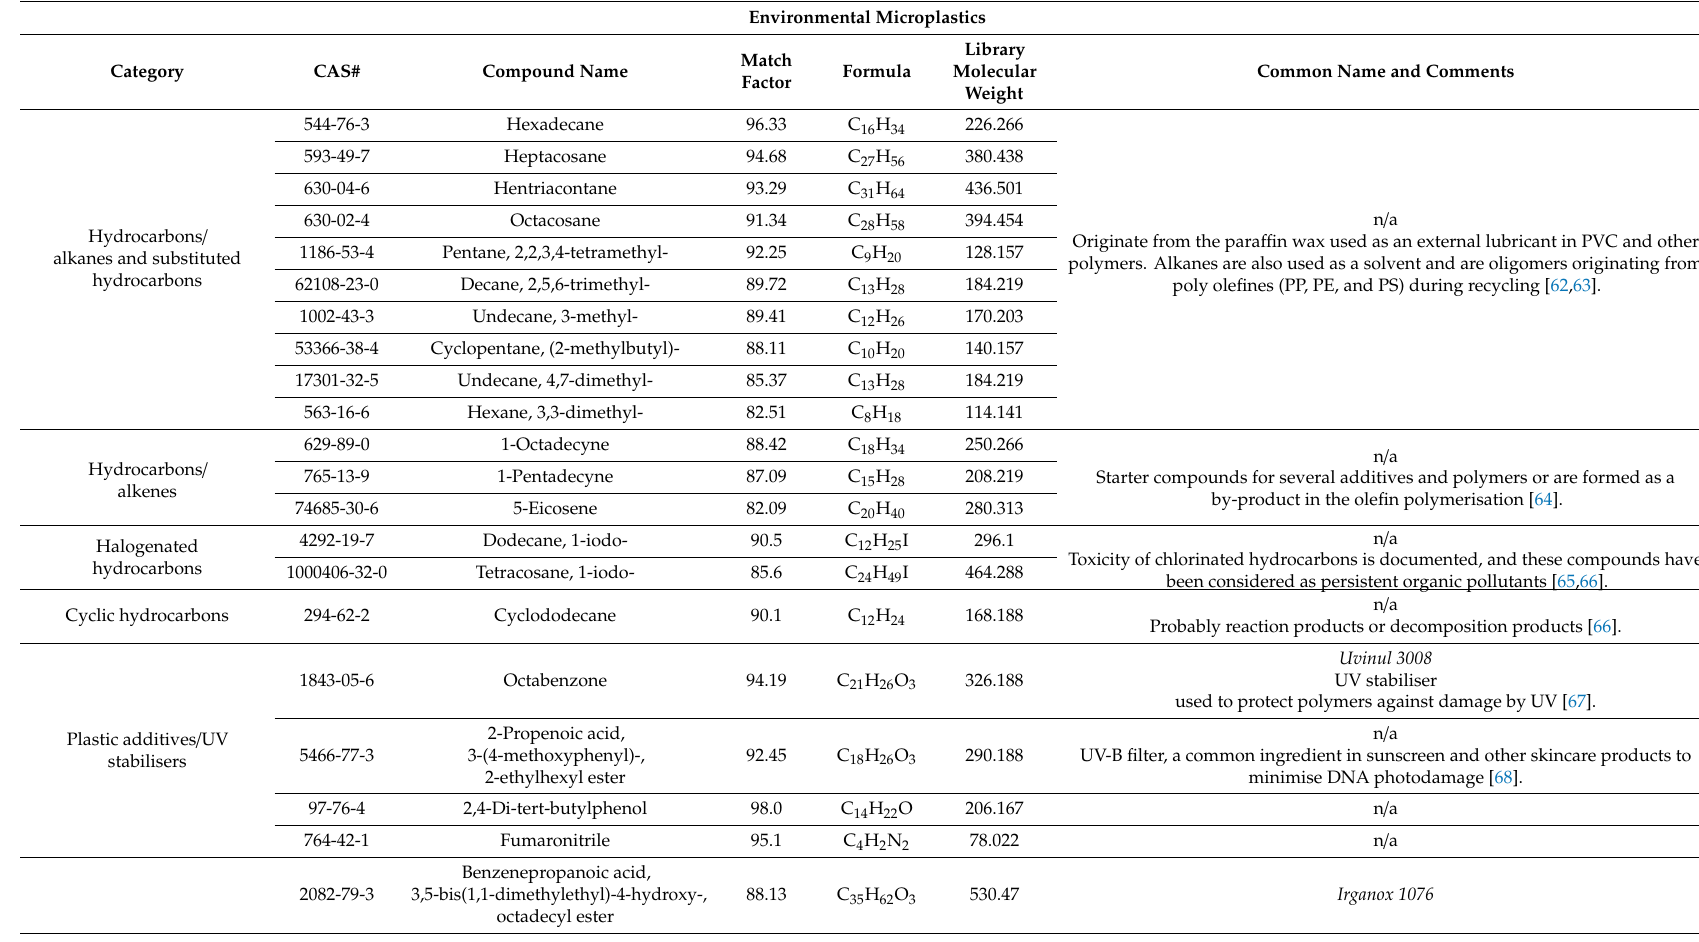
Table 2. Overview of 37 di ff erent types of compounds tentatively identified on environmental microplastic samples (April 2017, February 2017, December 2017, May 2018) by general screening. The chemicals are grouped according to their presumed source. CAS no. and NIST probability match factor % for each compound is shown, along with molecular weight and chemical formula. Where available, common name and comments also are given; otherwise n / a is